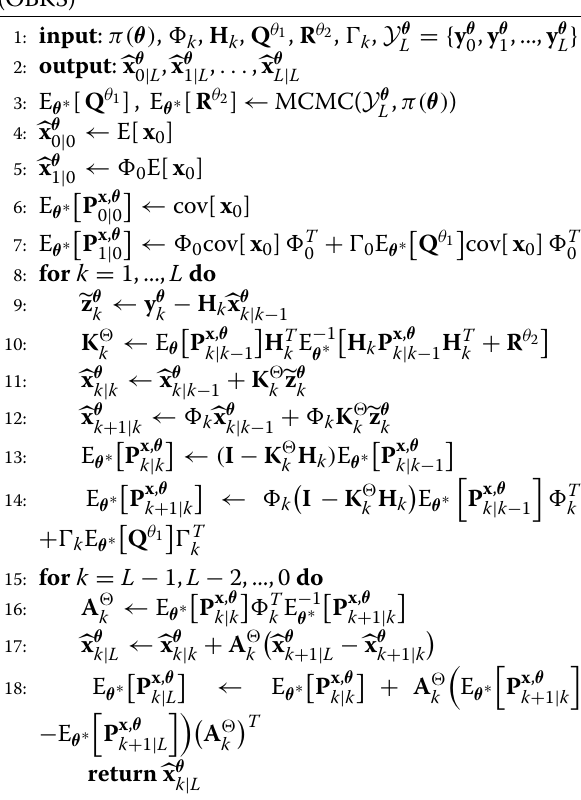
Algorithm 1 Optimal Bayesian Kalman